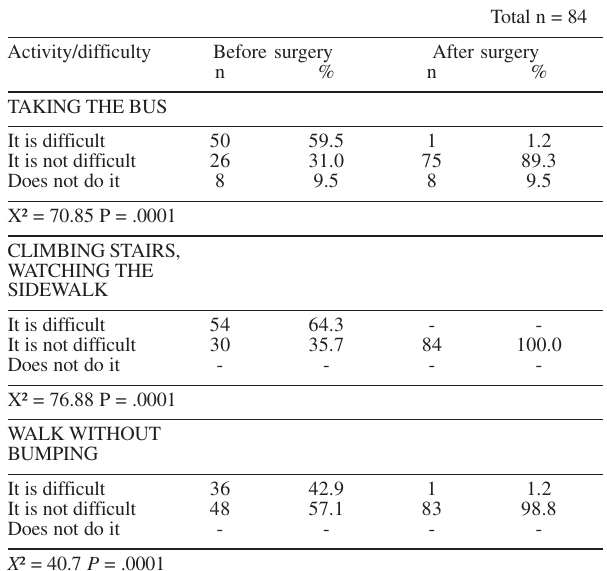
Table 3 - Difficulties in performing leisure activities before and after contralateral eye surgery (University Of São Paulo